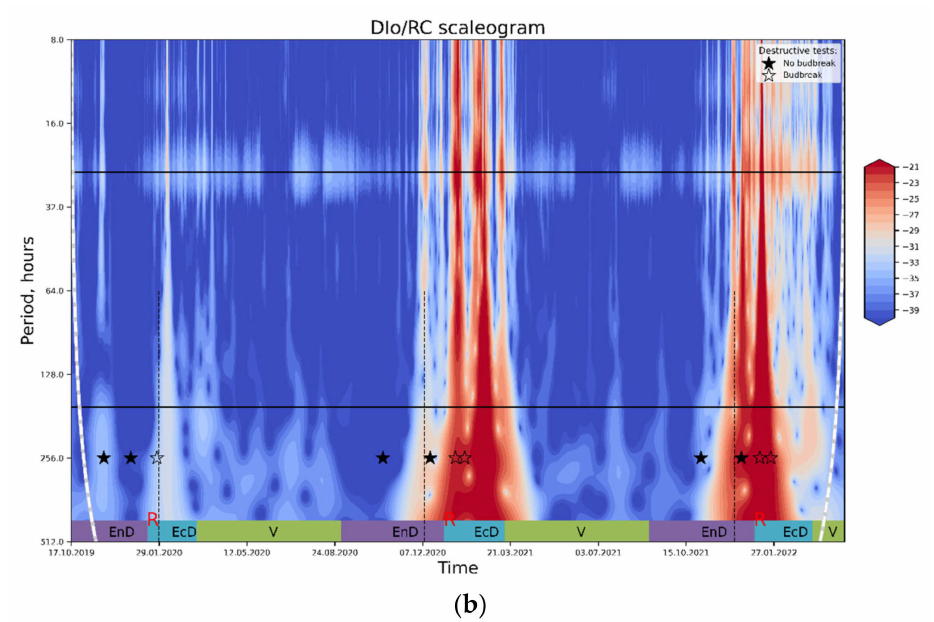
Figure 6. The results of wavelet transform analysis of ( a ) PS II Qy; ( b ) thermally dissipated energy flux per reaction center. An increase in spectral power pertinent to the processes influencing the OJIP parameter in question (red-colored regions on the plot) is tentatively ascribed to the periods of end-dormancy release and the onset of eco-dormancy. For explanations, see text. Annotations: top horizontal line, a period of 24 h; bottom horizontal line, a period of one week; rest-see the legend to Figure